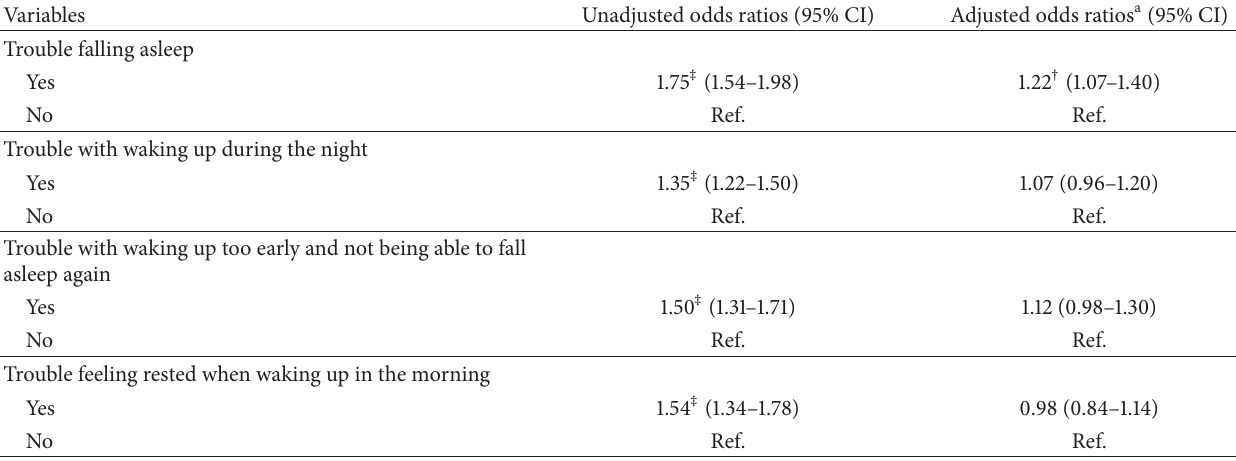
Table 6: Associations between type of sleep problems and falls in community-dwelling older adults in the US,